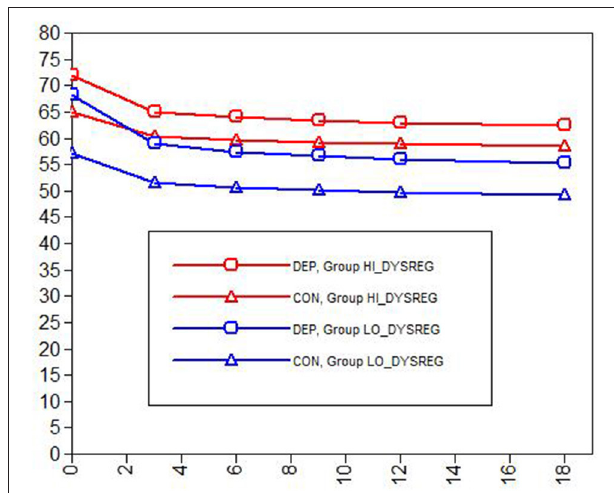
FIGURE 3 | Caregiver-rated internalizing problems by dysregulation group (HI vs. LO) and problem/protocol (CON vs. DEP). DEP, Depression problem focus, treated with CBT; CON, Conduct problems focus, treated with